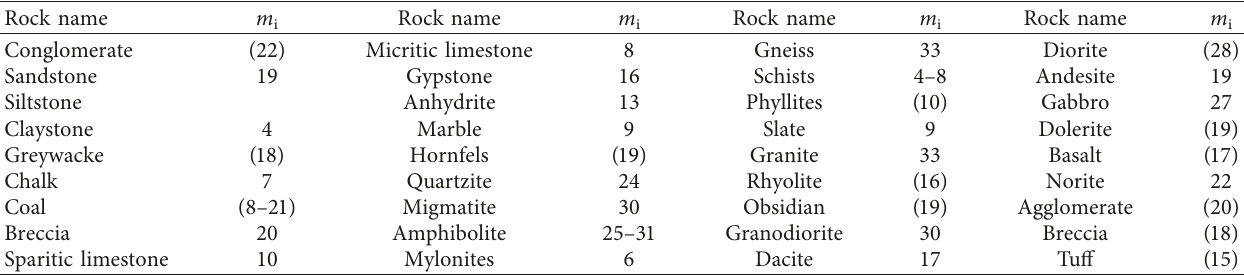
Table 3: The values of the constant m i for intact rock, by rock group. Note that values in parentheses are estimates of Hoek et al. [38].